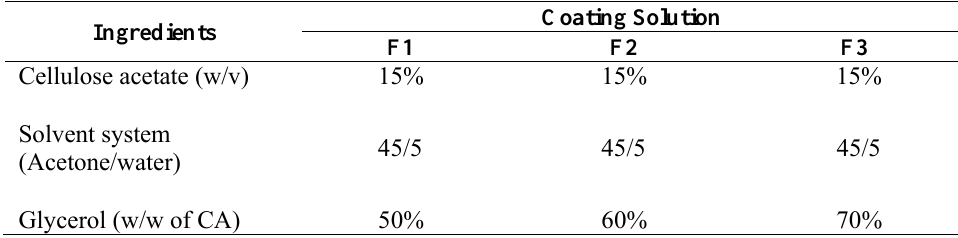
Table 1. Composition of coating